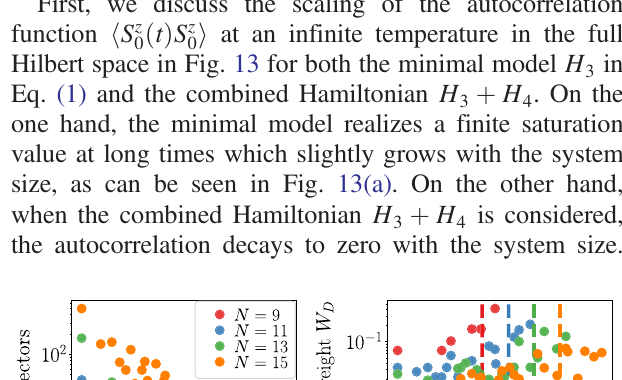
for ð 0 ; 0 Þ FIG. 14. (a) Autocorrelation function (upper) h S z 0 ð t Þ S z 0 i the symmetry sector q ¼ p ¼ 0 at an infinite temperature for H 3 (red curve) and H 3 þ H 4 (blue curve) for N ¼ 15 . Spatially resolved correlation functions for (b) H 3 and (c) H 3 þ H 4